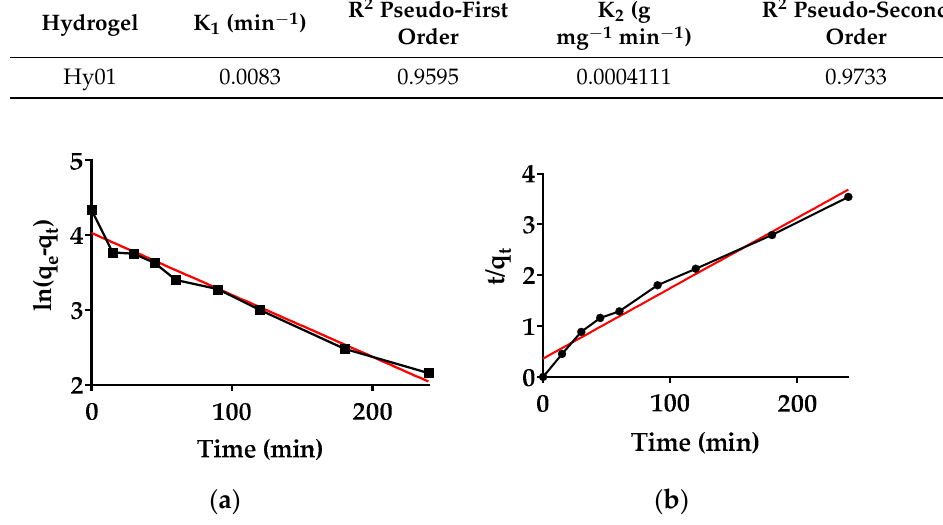
Figure 11. MO sorption kinetics: ( a ) pseudo-first-order and ( b ) pseudo-second-order kinetic model.